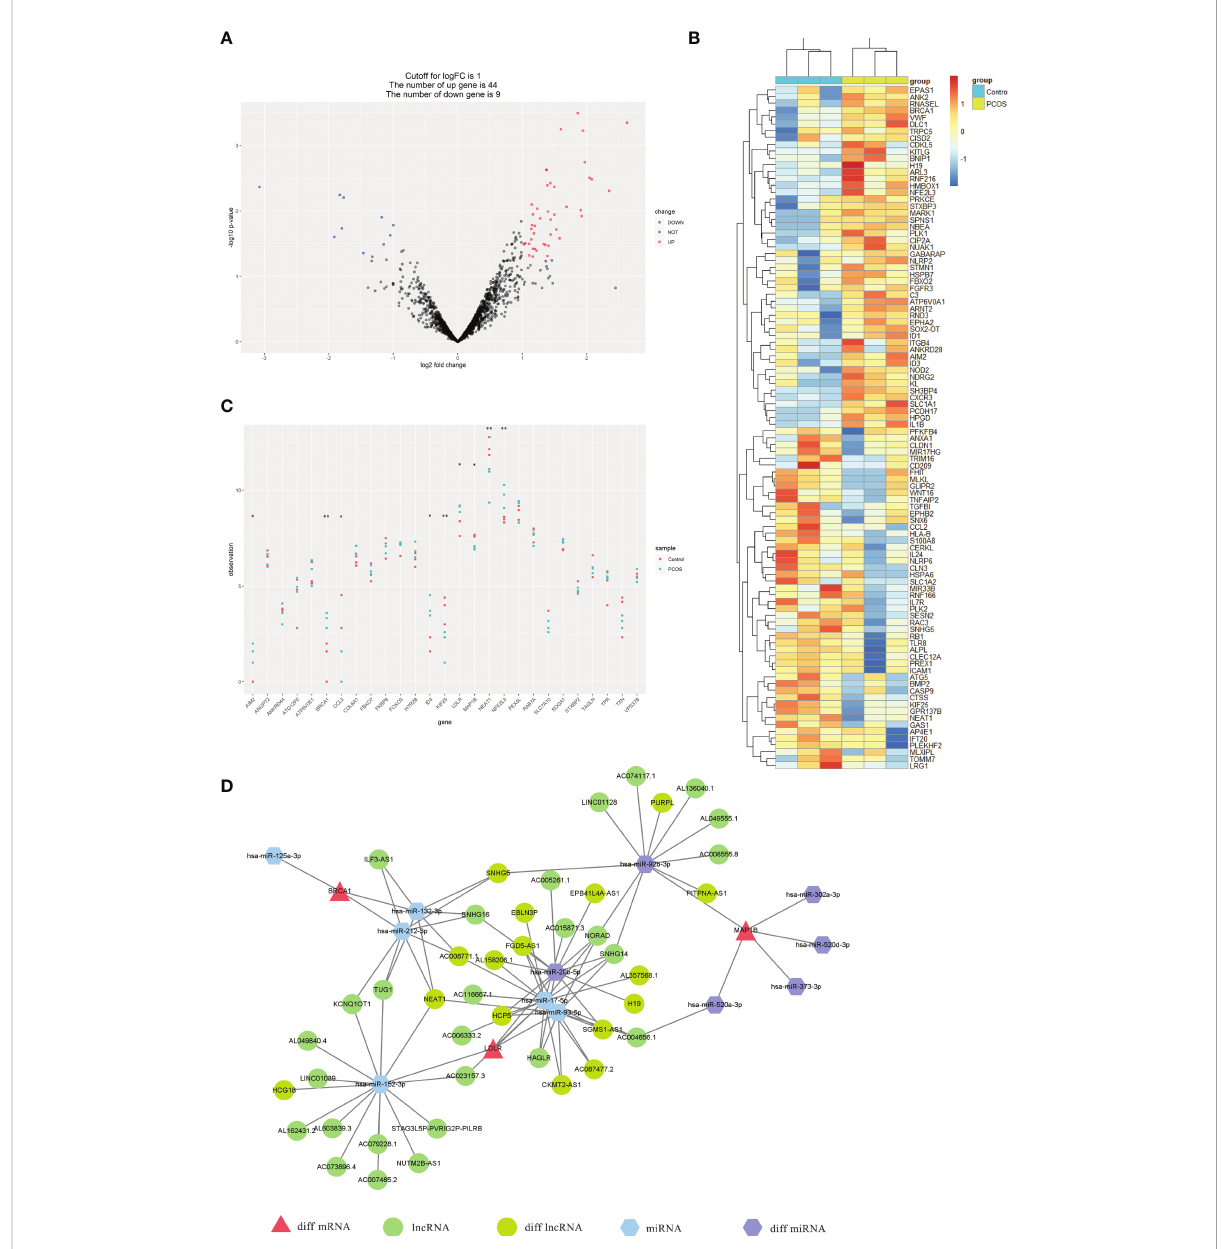
FIGURE 8 Expression pro fi les of ATGs by RNA-seq and construction of the multifactorial PCOS-autophagy-related network. (A) Volcano plots visualized RNA-seq results showing differential expression ATGs. The differences between the groups are plotted on the X-axis. The log10(p-value) for the differences is plotted on the Y-axis. (B) Heatmap showing the differential expression ATGs by RNA-seq. The columns represent healthy controls (blue columns) and PCOS patients(yellow columns). Red rows indicate up-regulation, whereas blue rows indicate down-regulation. The darker the color, the greater the difference. (C) Scatter plot showing the expression of hub ATGs via RNA-seq between healthy controls (red node) and PCOS patients (blue node). p<0.05 was considered statistically signi fi cant. **: p < 0.01, *: p < 0.05. (D) The mRNA-miRNA-lncRNA multifactorial network visualized by Cytoscape consists of 3 mRNAs (red triangles), 6 miRNAs (blue and purple hexagons), and 16 lncRNAs (green